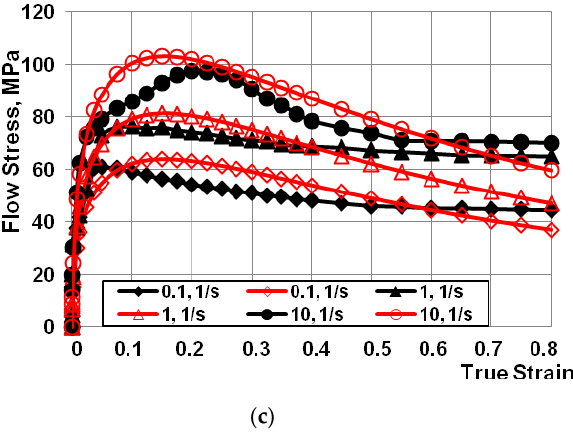
Figure 2. Work-hardening curves for the strain rate range of (0.1 s − 1 –10.0 s − 1 ) at a temperature of: ( a ) 200 °C, ( b ) 300 °C; ( c ) 400 °C. (Black indicates the experimental curves; red indicates the approximated curves). Table 2. Parameter values obtained from the approximation of Equation (1).